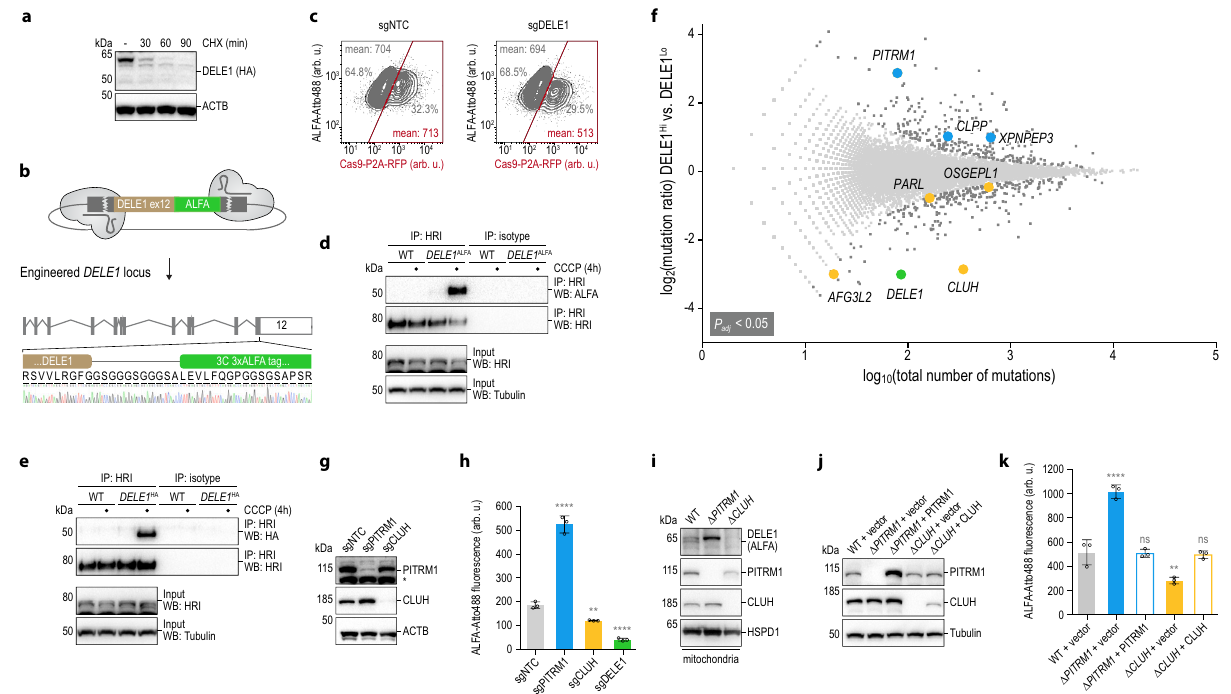
Fig. 1 Genome-wide screen for regulators of DELE1. a HeLa cells expressing endogenous DELE1 HA were treated with cycloheximide (CHX) and analyzed by immunoblotting. ACTB, β -actin. b The endogenous DELE1 locus in HAP1 cells was engineered with a C-terminal triple ALFA tag using CRISPR-Cas9. In- frame fusion veri fi ed by Sanger sequencing. c HAP1 DELE1 ALFA cells were lentivirally transduced to express a single guide non-targeting control (sgNTC) or an sgRNA targeting DELE1 (sgDELE1) together with Cas9-P2A-RFP at a multiplicity of infection < 1, such that each population comprises sgRNA-containing cells (RPF + ) and non-transduced wild-type cells. DELE1 ALFA was stained with Atto488, values specify mean Atto488 intensity in transduced (RFP + ; red box) and non-transduced (RFP-) cells. d , e HAP1 cells of the indicated genotypes were treated with CCCP and the ability of endogenous HRI to co- precipitate the respective S-DELE1 proteins was analyzed by immunoblotting. WT, wild-type. f Haploid genetic screen for regulators of DELE1. Per gene (dots), the ratio of the frequency of mutations in DELE1 ALFA -high versus DELE1 ALFA -low cells ( y -axis) is plotted against the combined number of unique mutations identi fi ed in both populations ( x -axis). Genes signi fi cantly enriched for mutations in either population are dark gray or colored (two-sided Fisher ’ s exact test, FDR-corrected P -value ( P adj ) < 0.05). g HAP1 DELE1 ALFA cells were exposed to sgRNAs as indicated. Knockout ef fi ciency was analyzed by immunoblotting. Asterisk: nonspeci fi c band. h DELE1 protein levels (cells as in ( g )) analyzed by fl ow cytometry. Mean ± s.d. of n = 3 independent biological samples (arb. u., arbitrary units). Statistical signi fi cance compared to sgNTC assessed using ordinary one-way ANOVA with Dunnett ’ s multiple comparisons correction. **** P < 0.0001, ** P = 0.0094. i Mitochondrial DELE1 protein levels of clonal HAP1 DELE1 ALFA PITRM1 or CLUH knockout cells analyzed by immunoblotting. j Clonal HAP1 DELE1 ALFA PITRM1 and CLUH knockout cells reconstituted with the respective cDNAs or vector control analyzed by immunoblotting. k DELE1 protein levels (cells as in ( j )) analyzed by fl ow cytometry. Mean ± s.d. of n = 3 independent biological samples. Statistical signi fi cance compared to WT + vector assessed with ordinary one-way ANOVA and Dunnett ’ s multiple comparisons correction; ns,